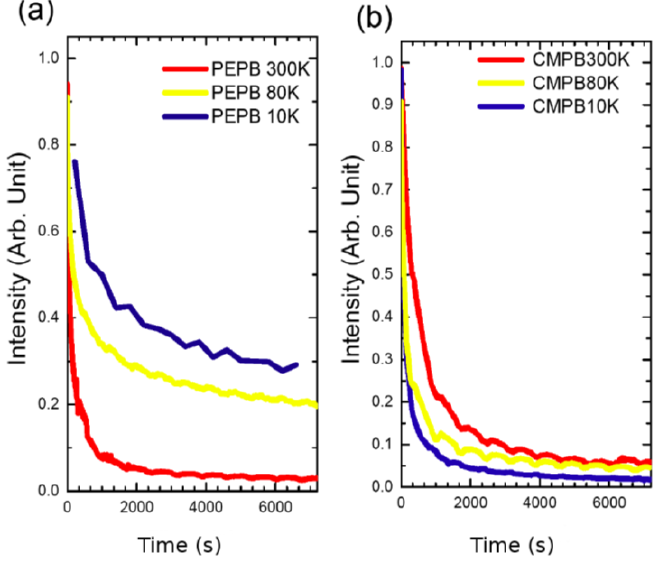
Figure 10. Evolution of PL intensity as a function of illumination time at different temperatures. The laser power is 7 mW (corresponding to a fluence 0.175 W·cm −2 ) at 325 nm. ( a ) PEPB and ( b ) CMPB in helium environment. The influence of temperature is atypical for